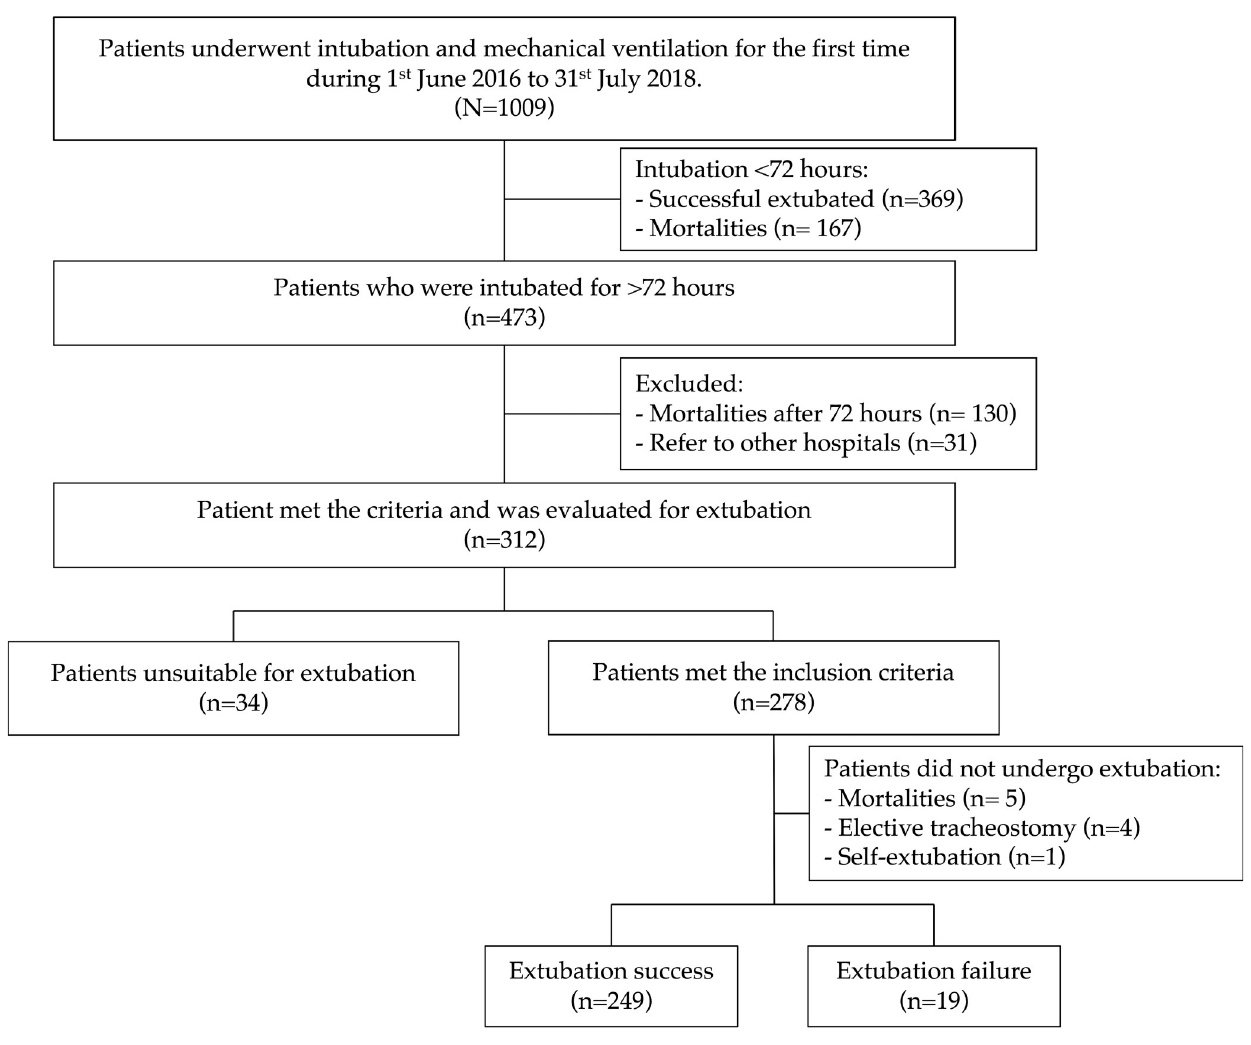
Fig 1. Study flow and included